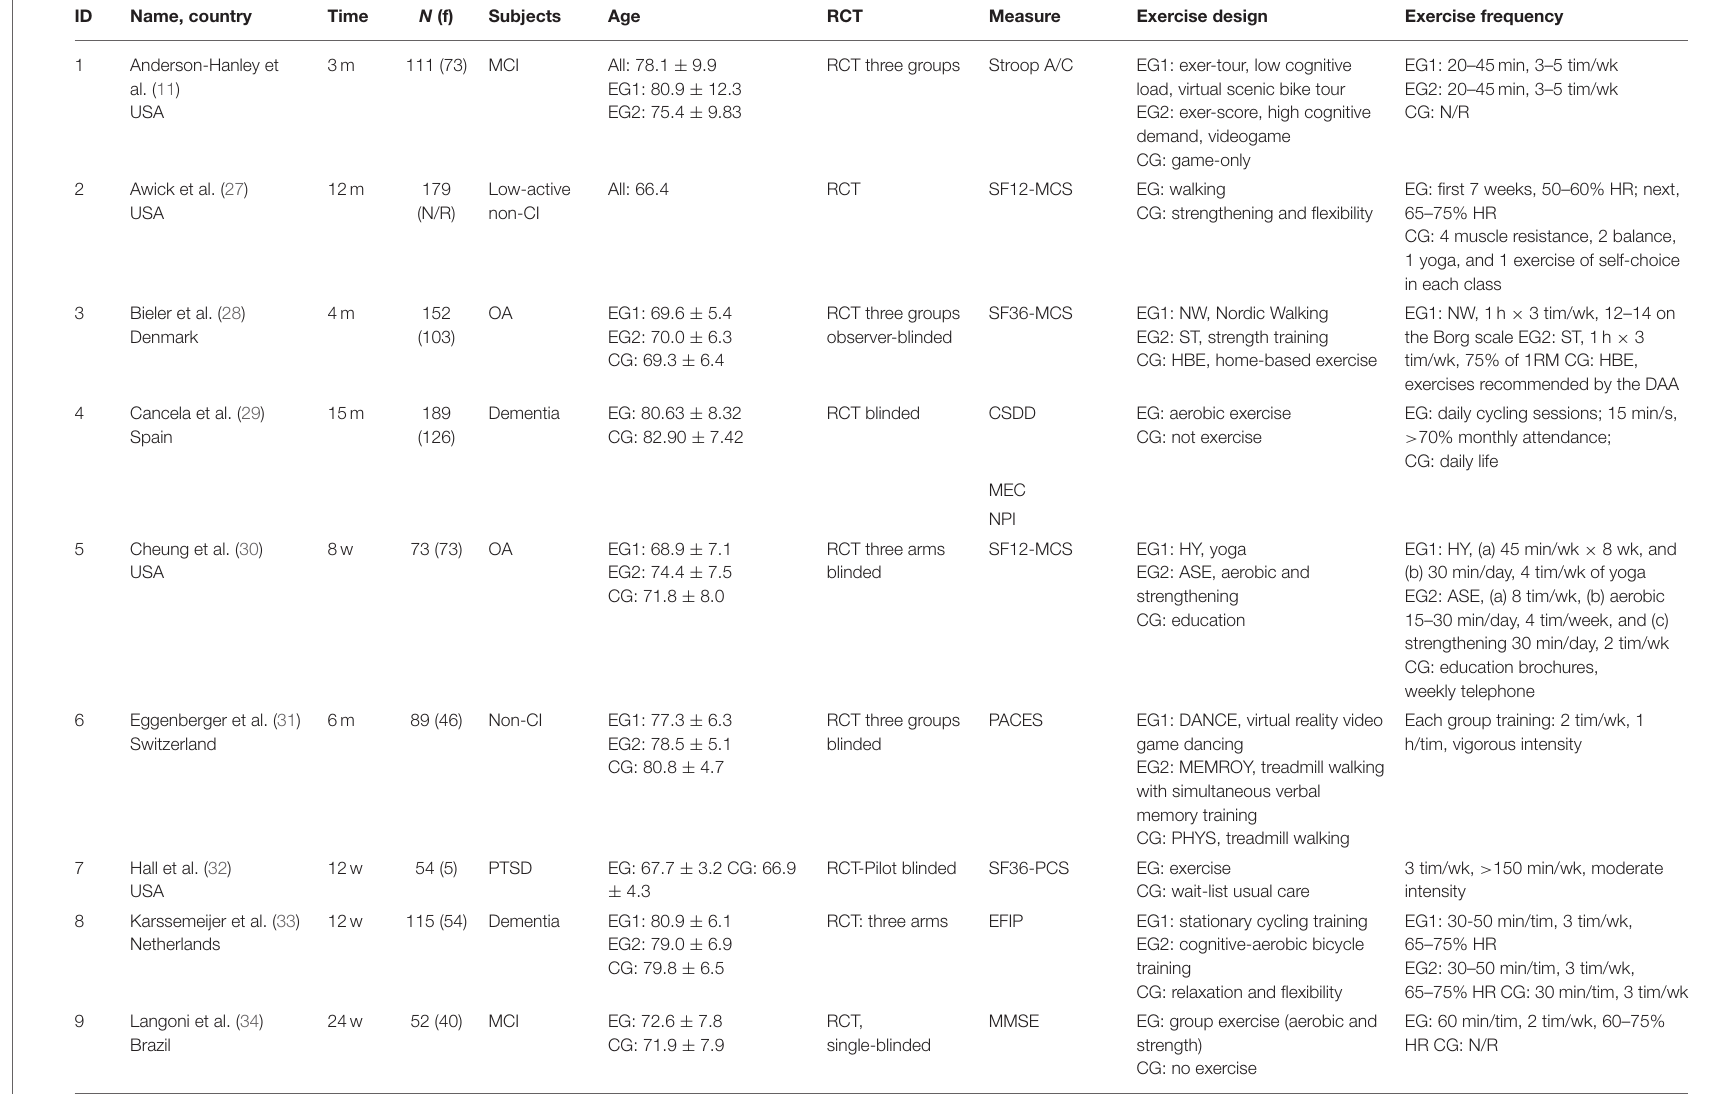
TABLE 1 | The characteristics of sources of